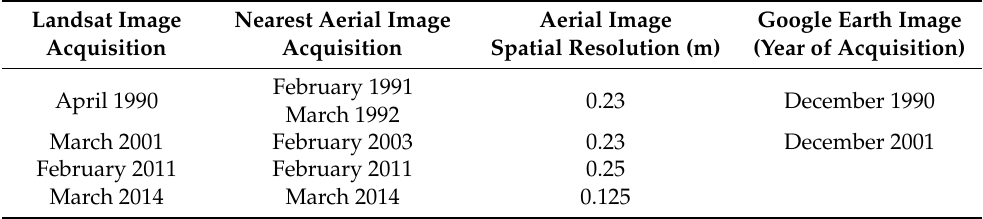
Table 2. Available aerial, Google Earth images corresponding to historic Landsat images